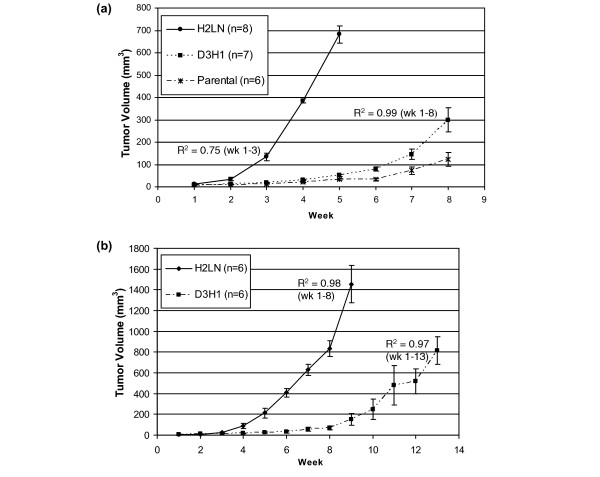
Mammary tumor growth is enhanced in D3H1 and D3H2LN bioluminescent sublines of MDA-MB-231 cells. Cells were injected into the mammary fat pad of (a) nude or (b) nude-beige mice, and mean tumor volumes were determined by caliper measurements over time. The tumors from the bioluminescent sublines D3H1 and D3H2LN were also monitored using in vivo imaging, and the correlation between mean photons/s and mean tumor volume are indicated as R2 values.